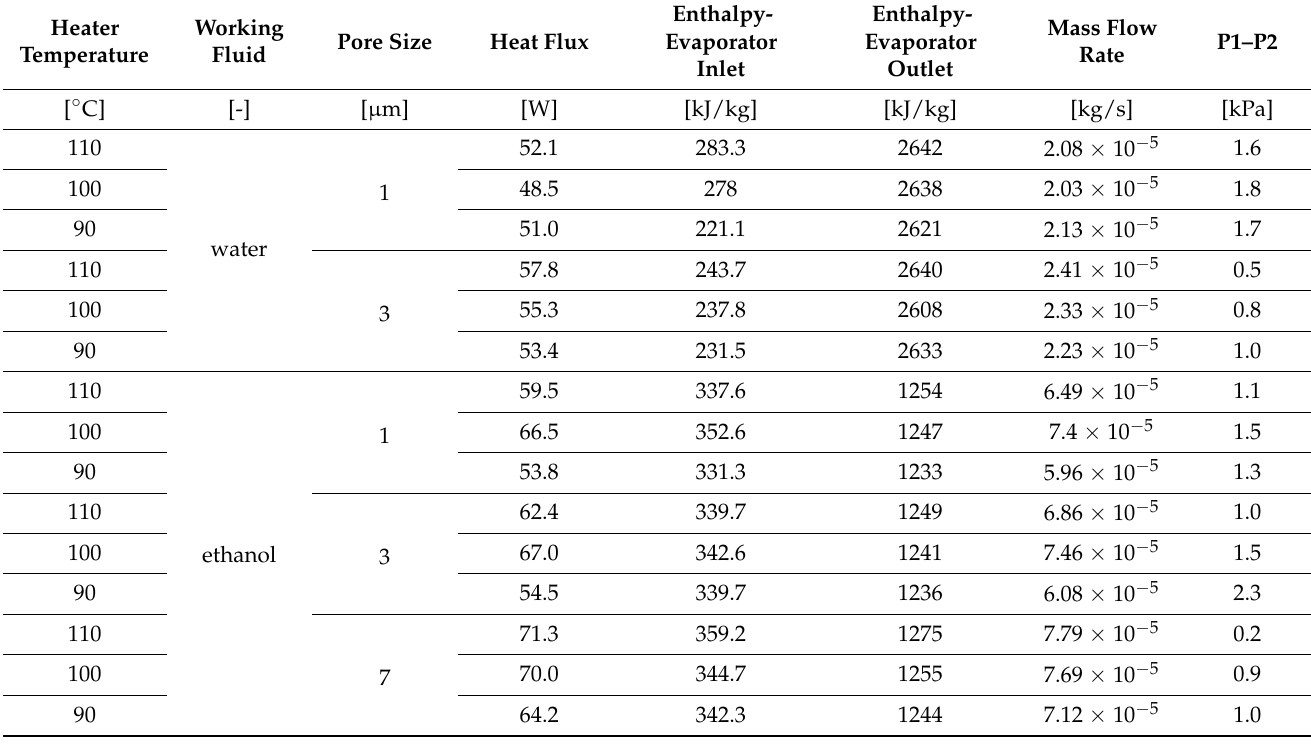
Table 5. Determination of the mass flow rate using the heat balance